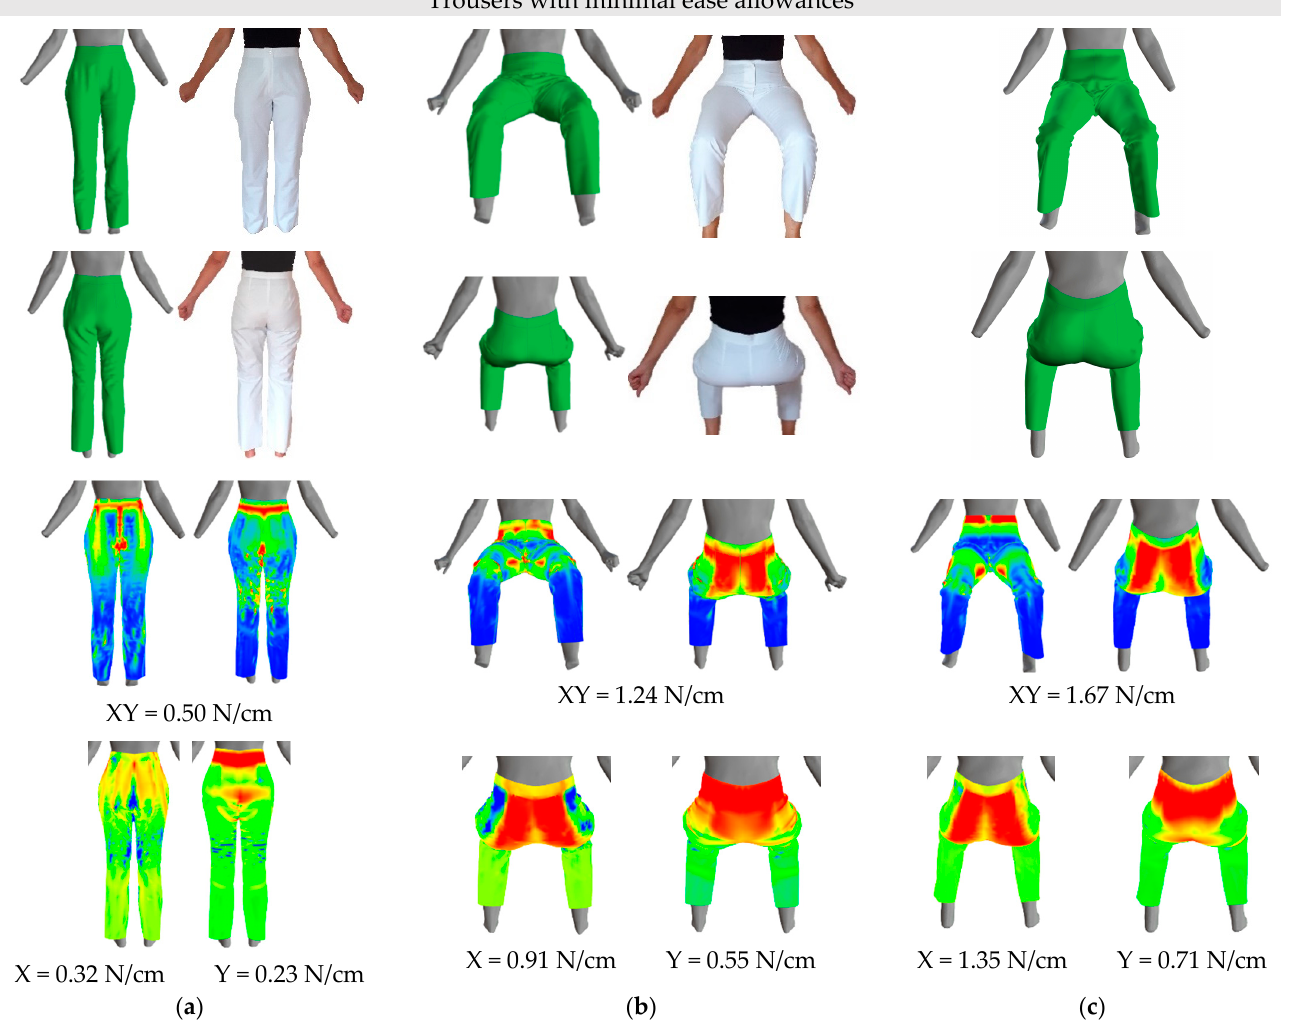
Figure 10. Virtual and real-trouser prototypes with minimal ease allowances and tension in trouser fabric: ( a ) standing 3D body model and real person, ( b ) sitting 3D body model and real person, ( c ) kinematic sitting 3D body model.